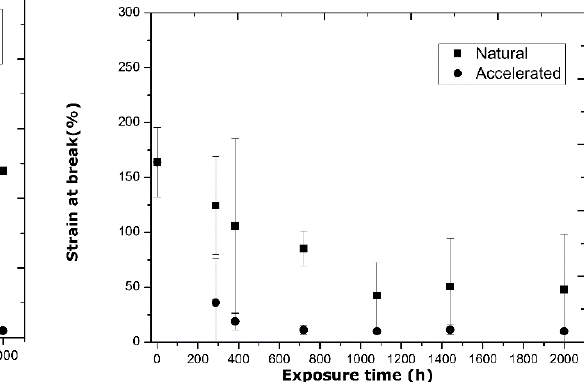
Figure 9. The strain at break as a function exposure time for natural and accelerated